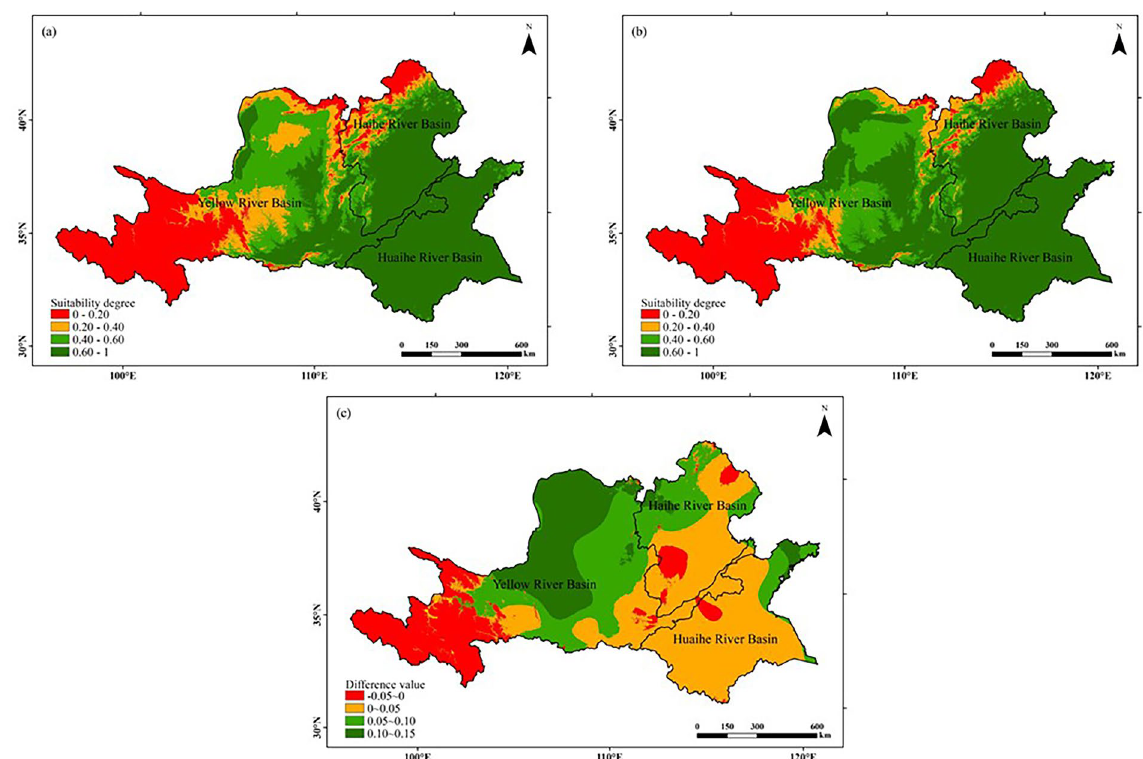
Figure 6. Comparison of the distribution of temperature suitability for peanut growing seasons in the Huang- Huai-Hai region during two climatic years: ( a ) 1960–1989, ( b ) 1990–2019, ( c ) ( b )–( a ). The figure was made in the ArcGIS 10.2 platform (https:// www. esri. com/ en- us/ Most suitable region (0.60 ≤ S < 1): In 1960–1989 (former 30a), the most suitable planting area for peanut was mainly distributed in the west of the Haihe River Basin and most parts of the Huaihe River Basin, which accounted for approximately 31.31% of the total area in the study area. In 1990–2019 (latter 30a), the most suit- able planting area for peanut was expanded before and mainly concentrated in the north of the Huaihe River Basin, the south of the Haihe River Basin and the southwest of the Yellow River Basin, and the increased area accounted for approximately 5.94% of the study area. The growth season average temperature of the most suitable growing region for peanut is 20 ~ 25 °C, the cumulative precipitation is 600 ~ 1000 mm, the number of sunshine hours is 800 ~ 1400 h, and the heat, water and light resources are all suitable for peanut growth and development, which is the most ideal region for peanut cultivation. Suitable region (0.40 ≤ S < 0.60): In 1960–1989 (former 30a), peanut suitable planting areas were widely dis- tributed, mainly in the middle east of the Yellow River Basin, the middle west of the Haihe River Basin and the northern Huaihe River Basin, which cover approximately 20.88% of the total study area. In 1990–2019 (latter 30a), the range of peanut suitable planting area shifted to the west of the study area, and the area has increased, accounting for 25.09% of the total area in the study area. The climatic conditions in peanut suitable growing areas for peanut production were overall slightly less suitable than those in the most suitable areas, but were able to meet the needs of normal growth and development of peanut, and suitable for peanut growth. Sub-suitable regions (0.20 ≤ S < 0.40): In 1960–1989 (former 30a), peanut sub-suitable planting areas were mainly distributed in the central and northern Yellow River Basin, the northern Haihe River Basin and the northeast corner of the Huaihe River Basin, and the area occupied approximately 24.15% of the total study area. In 1990–2019 (latter 30a), the area of the sub-suitable planting area of peanut decreased compared with that before, and overall shifted to the northwest. The comprehensive suitability of peanut sub-planting regions was poor, and the reasons for poor comprehensive suitability were different in different regions. Unsuitable regions (S < 0.20): In 1960–1989 (former 30a), the distribution of peanut unsuitable growing areas was large, which cover approximately 23.66% of the total area in the study area and mainly exists in the west and north of the study area, with the Yellow River Basin dominated by the west. A 3.59% decrease in peanut unsuitable growing areas occurred in 1990–2019 (latter 30a), mainly in the north and west of the Yellow River Basin. The climatic conditions of not suitable regions are extremely low suitable for peanut cultivation, and inhospitable for peanut cultivation. Verification of peanut climatic zoning results in Huang‑Huai‑Hai region. To verify the rationality of the results of the evaluation of the climatic suitability of peanut in the Huang-Huai-Hai region, two aspects are considered in this paper. The former is the occurrence of peanut disasters in the Huang-Huai-Hai region,